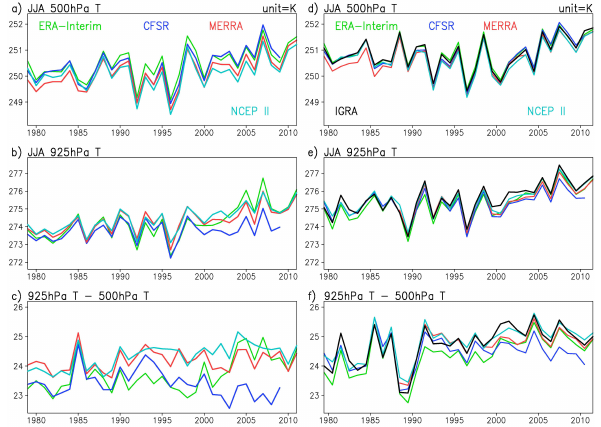
Fig. 4. Same as Fig. 3 except for the JJA (June, July and August) season.